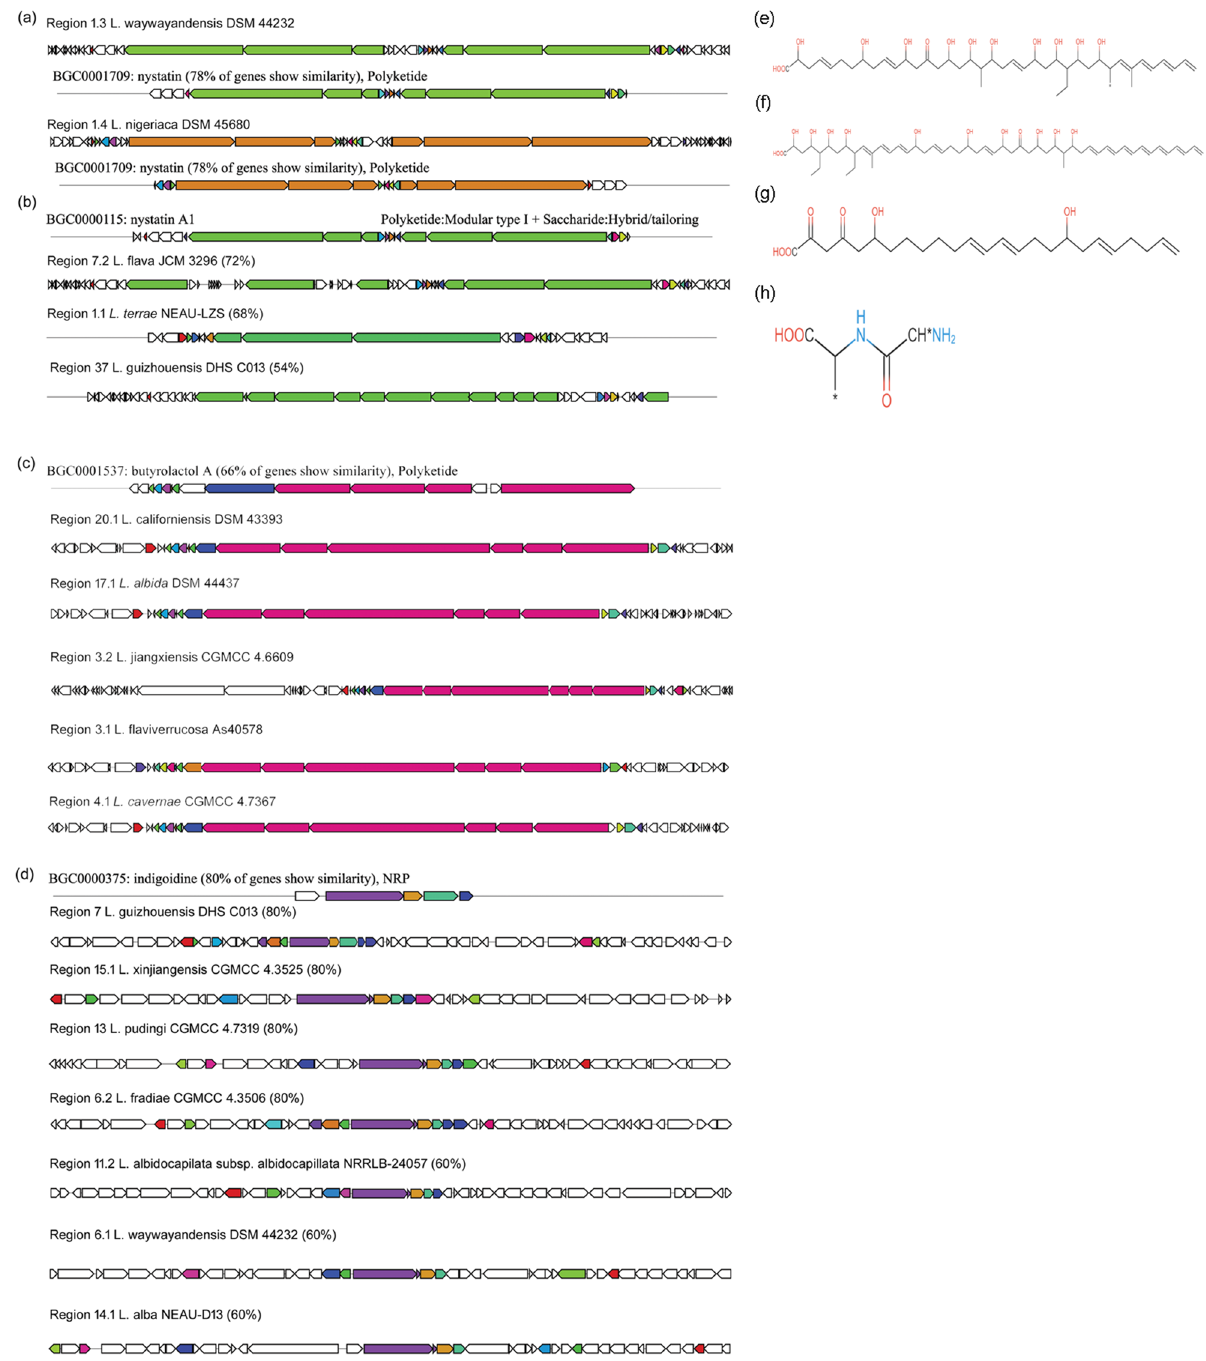
Figure 7. Highly similar antimicrobial gene clusters of Lentzea species compared with known clusters in the antiSMASH database. Gene clusters for Nystatin ( a ), Nystatin A1 ( b ), Butyrolactol A ( c ), Indigoidine ( d ); and the putative compounds produced by these clusters Nystatin ( e ), Nystatin A1 ( f ), Butyrolactol A ( g ), and Indigoidine ( h